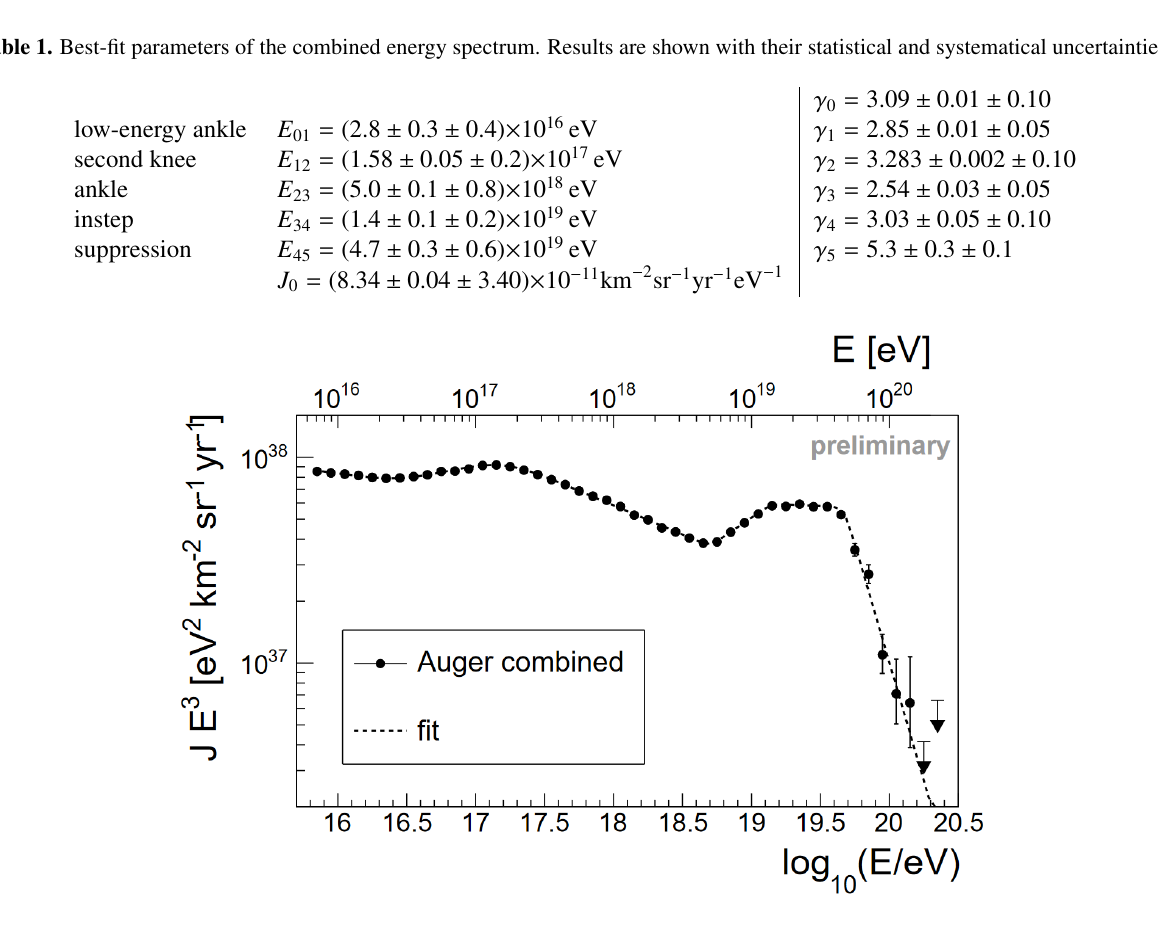
Table 1. Best-fit parameters of the combined energy spectrum. Results are shown with their statistical and systematical uncertainties.